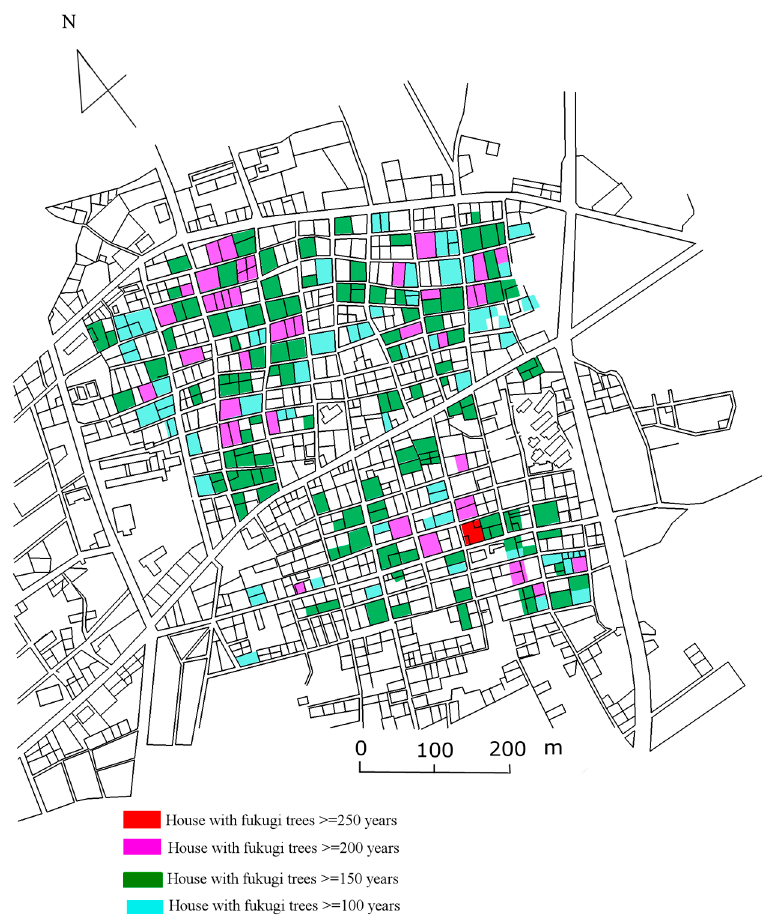
Figure 4. Spatial distribution of homesteads in Hirae and Maezato with old Fukugi trees.